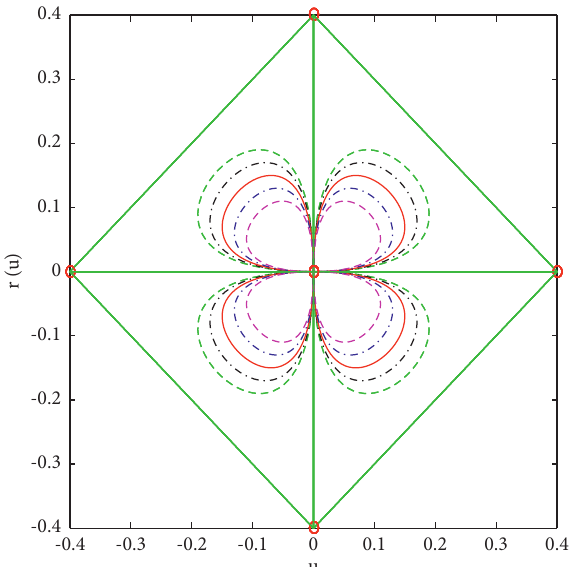
Figure 8: Flower designing using CT-B´ezier basis functions.